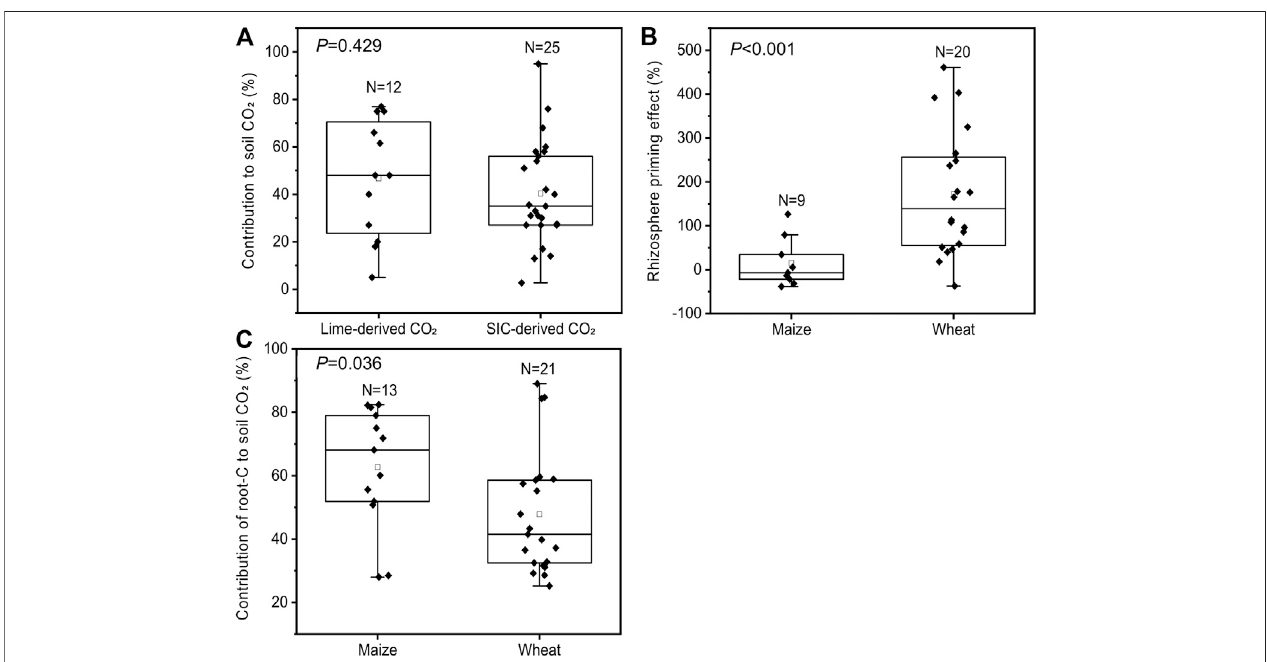
FIGURE7| Literature synthesis based on 13 C/ 14 C tracer experiments. Contribution of lime application in acidic soils or soil native inorganic C in carbonate- rich soils to total soil CO 2 emissions (A) , maize and wheat rhizosphereeffects on SOC decomposition (B) , and contribution ofroot-derived and soil-derived CO 2 to total CO 2 emissions from soils planted with maize and wheat (C) . Note (A) is based on a literature synthesis including 12 observations from 9 studies of lime application and 25 observations from 24 studies of soil CO 2 partitioning in carbonate-rich soils ( Supplementary Table S2 ) (B) is based on a literature synthesis including 9 observations from 5 studies of the maize rhizosphere effect and 20 observations from 8 studies of the wheat rhizosphere effect ( SupplementaryTable S3 ) (C) isbasedon aliteraturesynthesisincluding13observationsfrom 8studiesofmaizeand 21observationsfrom6studiesofwheat ( Supplementary Table S4 ); the N in the box represents the number of data points; the line and square within the box represent the median and mean values of all data; the bottom and top edges of the box represent 25 and 75 percentiles of all data, respectively; and the bottom and top bars represent 5 and 95 percentiles of all data, respectively; the scattered black diamonds indicate data